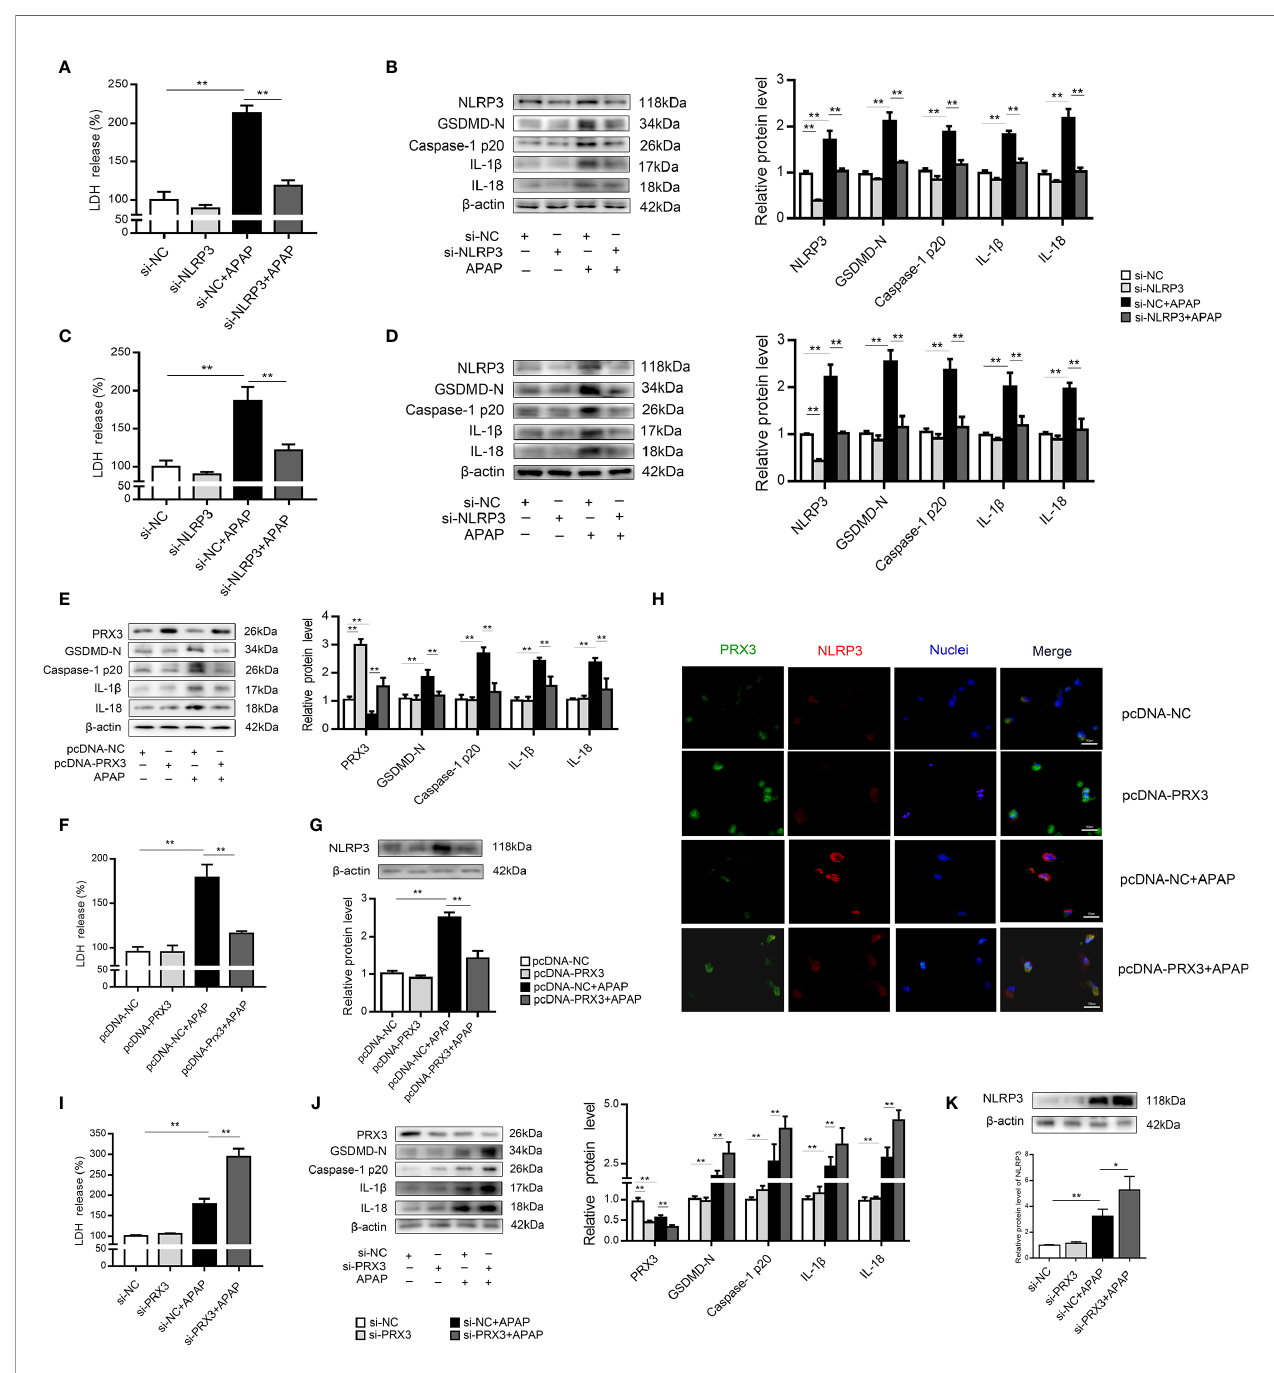
FIGURE 4 | PRX3 regulates NLRP3-mediated pyroptosis in APAP-induced hepatotoxicity in vitro. Primary KCs and hepatocytes were transfected with NLRP3- speci fi c siRNA and then exposed to APAP (10 mM). (A) Kupffer cellular supernatant levels of LDH were assessed, n=6. (B) NLRP3, GSDMD-N, caspase-1 p20, IL- 1 b , and IL-18 protein levels in primary KCs, n=3. (C) Hepatocellular supernatant levels of LDH were assessed, n=6. (D) NLRP3, GSDMD-N, caspase-1 p20, IL-1 b , and IL-18 protein levels in primary hepatocytes, respectively, n=3. (E) Primary hepatocytes were transfected with pcDNA-PRX3 and then exposed to APAP (10 mM). PRX3, GSDMD-N, caspase-1 p20, IL-1 b , and IL-18 protein levels in primary hepatocytes were determined, n=3. (F) Hepatocellular supernatant levels of LDH were assessed, n=6. (G) NLRP3 protein levels in primary hepatocytes, n=3. (H) Double immuno fl uorescence staining for PRX3 and NLRP3 in primary hepatocytes, 50 m m. (I) Hepatocellular supernatant levels of LDH were assessed, n=6. (J) Primary hepatocytes were transfected with si-PRX3 and then exposed to APAP (10 mM). PRX3, GSDMD-N, caspase-1 p20, IL-1 b and IL-18 protein levels in primary hepatocytes were determined, n=3. (K) NLRP3 protein levels in primary hepatocytes, n=3. **P<0.01,